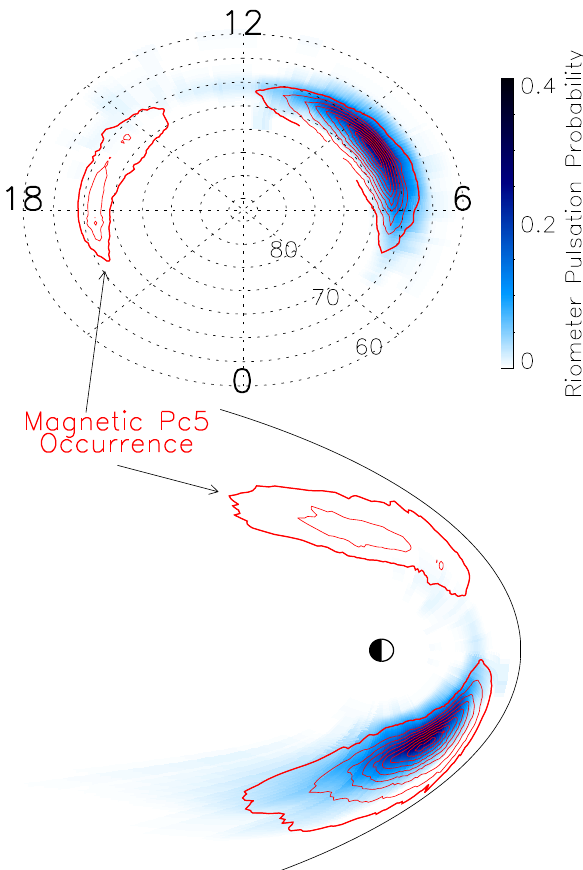
Fig. 5. Relative occurrence of magnetic and riometer Pc5 pulsa- tions. The color level plot indicates the probability of observing a riometer pulsation given a magnetic pulsation. Contours of mag- netic Pc5 occurrence (from Baker et al., 2003) are shown in red. We have filled in the notch in that survey to make the contours con- tinuous (see Fig.